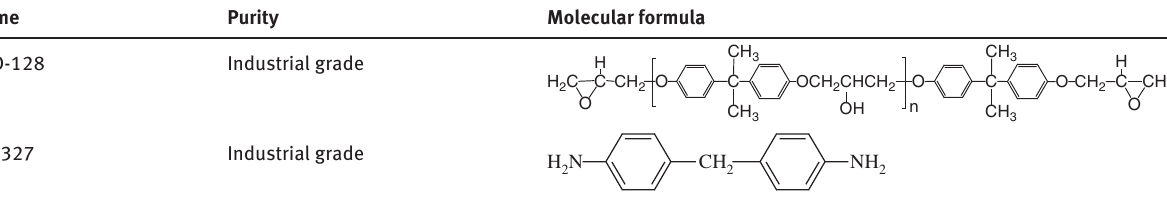
Table 1: Purity and molecular formula of CYD-128/GA-327. Name Purity